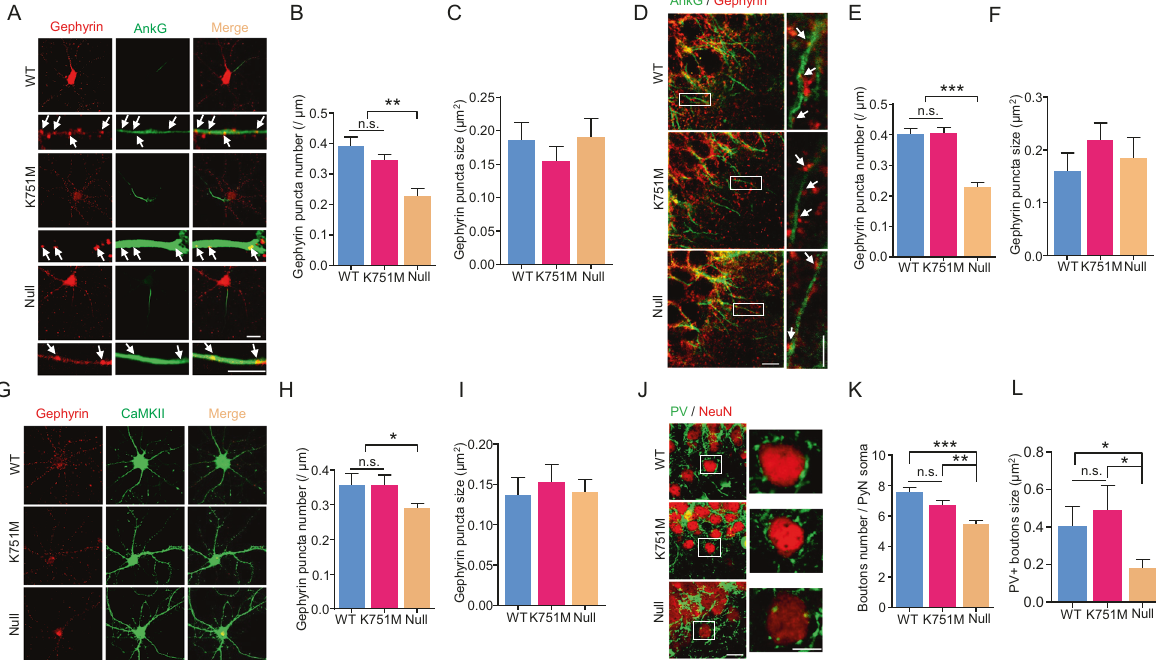
Fig. 3 ErbB4 protein, but not its kinase activity, is important for inhibitory synapse formation. A – C AIS gephyrin puncta number was decreased in primary Null hippocampal neurons, but not in K751M neurons. Representative images of gephyrin + inhibitory synapses onto AnkG + AIS of cultured hippocampal PyNs ( A ). Arrows indicate gephyrin puncta contacting with AIS. Scale bar, 20 μ m for lower magni fi cation images and 10 μ m for enlarged magni fi cation images. Quantitative analysis of AIS gephyrin puncta number ( B ) and size ( C ) in A . n = 39 neurons for WT, n = 35 neurons for K751M, and n = 20 neurons for Null. D – F AIS gephyrin puncta number was decreased in the hippocampus of Null mice, but not K751M mice. Representative images of gephyrin + inhibitory synapses onto AnkG + AIS of CA1 PyNs in brain slices. Boxed areas were enlarged in the respective right images ( D ). Arrows indicate gephyrin puncta contacting with AIS. Scale bar, 10 μ m for lower magni fi cation images and 5 μ m for enlarged images of boxed areas. Quantitative analysis of AIS gephyrin puncta number ( E ) and size ( F ) in D . n = 28 neurons from four WT, n = 28 neurons from four K751M, and n = 28 neurons from four Null mice. G – I Perisomatic gephyrin puncta number was decreased in primary Null hippocampal neurons, but not in K751M neurons. Representative images of gephyrin + inhibitory synapses onto perisoma of cultured hippocampal PyNs ( G ). Scale bar, 20 μ m. Quantitative analysis of AIS gephyrin puncta number ( H ) and size ( I ) in G . n = 20 neurons for WT, n = 25 neurons for K751M, and n = 25 neurons for Null. J – L Perisomatic gephyrin puncta number was decreased in the hippocampus of Null mice, but not K751M mice. Representative images of gephyrin + inhibitory synapses onto perisoma of CA1 PyNs in brain slices. Boxed areas were enlarged in the respective right images ( J ). Scale bar, 10 μ m for lower magni fi cation images and 5 μ m for enlarged images of boxed areas. Quantitative analysis of perisomatic gephyrin puncta number ( K ) and size ( L ) in D . n = 30 neurons from four WT mice, n = 35 neurons from four K751M mice, and n = 32 neurons from four Null mice. Data were shown as mean ± SEM, * p < 0.05, ** p < 0.01, *** p < 0.001, n.s. p > 0.05. One-way